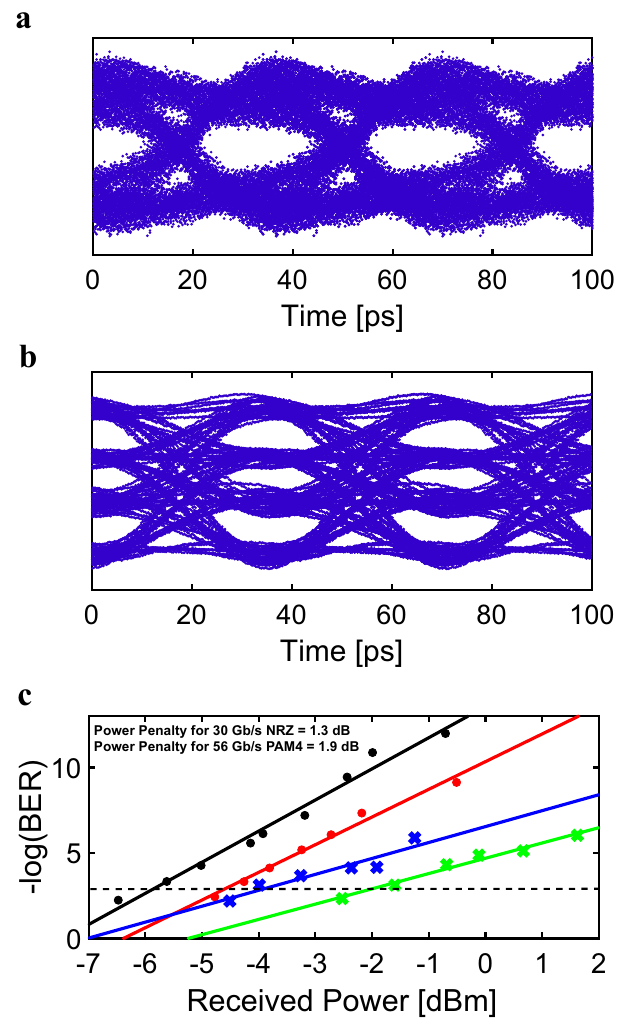
Fig. 2 | Experimentally measured eye diagrams and BER at the output of the boundarywaveguide.a , b Anopeneyeisobservedinbothcasesfor a 30Gb/sNRZ and b 56Gb/s PAM4 data. c Experimentally measured plot of – log(BER) as a func- tion of powerreceivedatthe output of the USRN topologicalphotonicwaveguide, for 30Gb/s NRZ and 56Gb/s PAM4 data. The black dotted line shows the Forward Error Correction (FEC) threshold at BER=10 − 4 . The measured NRZ BER for the topological waveguide and B2B setup are shown as red and black circles, respec- tively. The measured PAM4 BER for the topological waveguide and B2B setup is shown as green and blue crosses